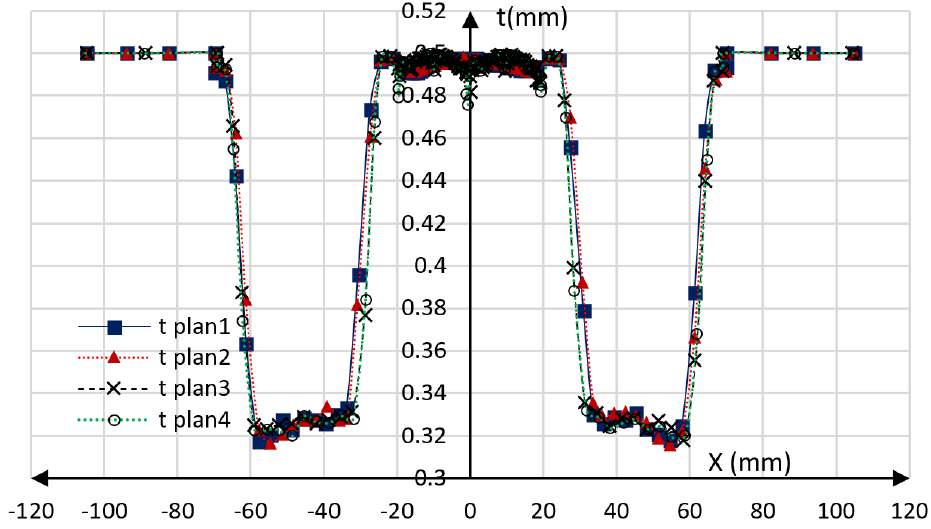
Figure 13. Predicted thicknesses distribution (tf) according to the four cutting planes for h = 40 mm